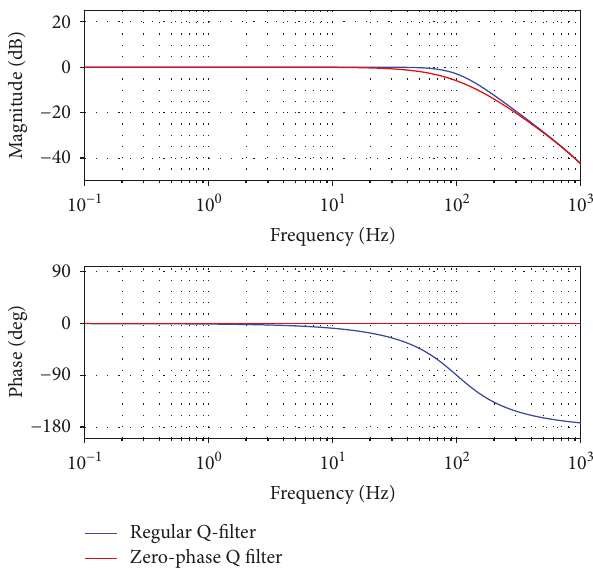
Figure 6: Frequency characteristic comparison of regular Q - fi lter and zero-phase Q - fi lter.